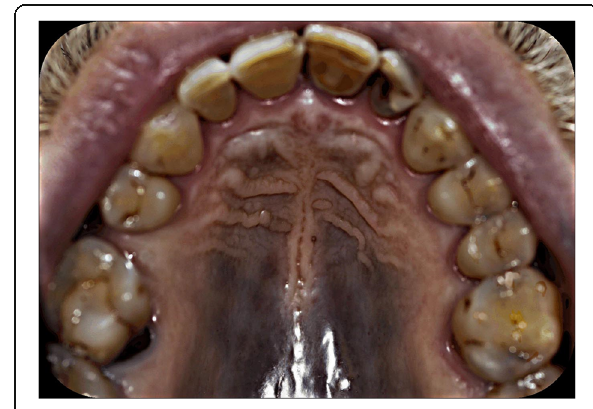
Fig. 1 An extensive blue – grey pigmented lesion of the hard palate mucosa evident on clinical examination